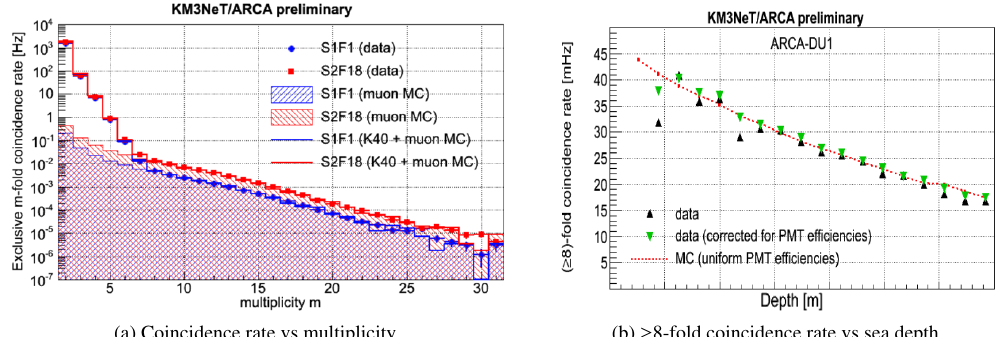
Figure 2: (a) Coincidence rate vs multiplicity. Two DOMs are shown: floor 1 (the lowest floor) of ARCA-DU1 and floor 18 (the highest floor) of ARCA-DU2. Data are compared to with the expecta- tions from MC simulations of 40 K and atmospheric muons [4]. (b) ≥ 8-fold coincidence rate vs depth below the sea surface for ARCA string 1. The statis- tical error bars are too small to be visible